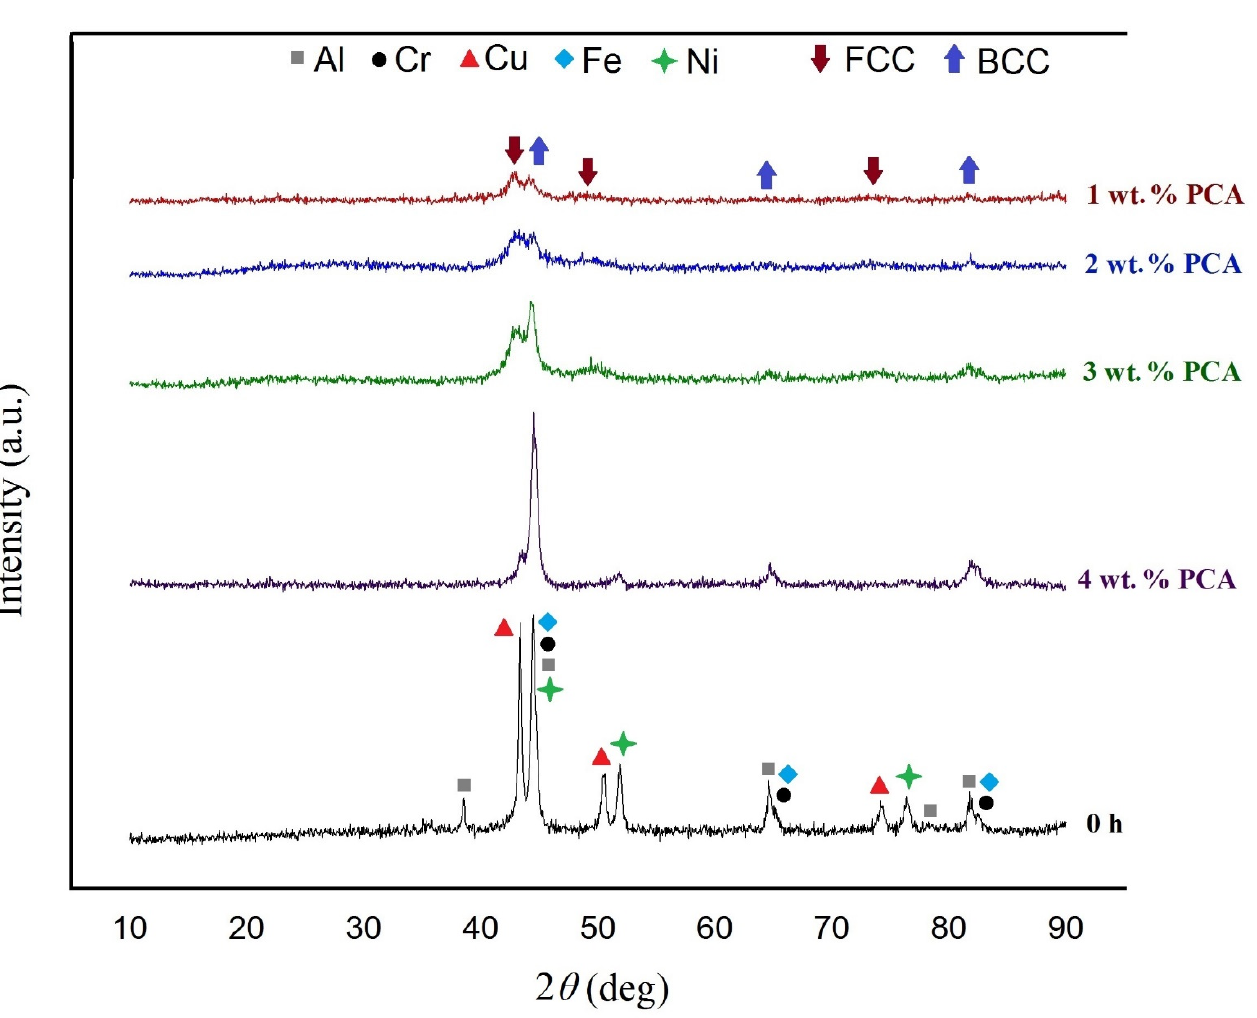
Figure 1. XRD patterns of AlCrCuFeNi alloy after 60 h of milling with different amounts of Process Control Agent—PCA (1, 2, 3, and 4 wt. %).